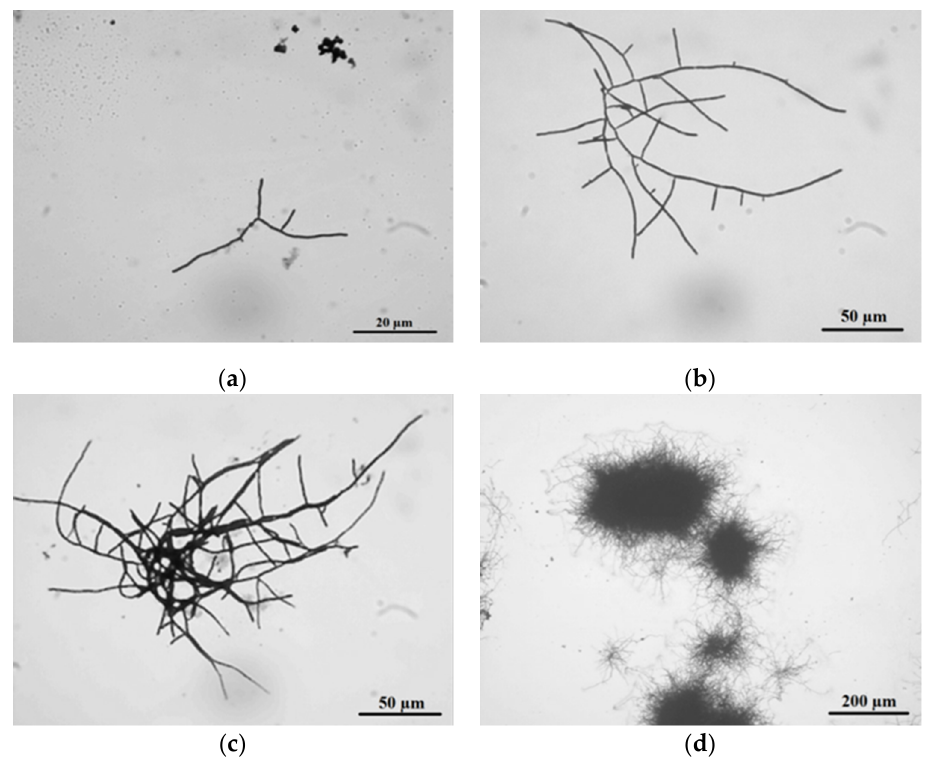
Figure 3. The life cycle of Streptomyces clavuligerus ATCC 27064 grown in TSB medium: ( a ) spore germination at 24 h; ( b ) branched hyphae at 28 h; ( c ) clump formation at 36 h; ( d ) pellet establishment at 45 h.